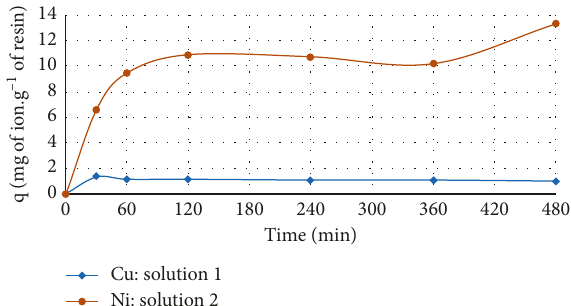
Figure 2: Results of effect of time of Solution 1 and Solution